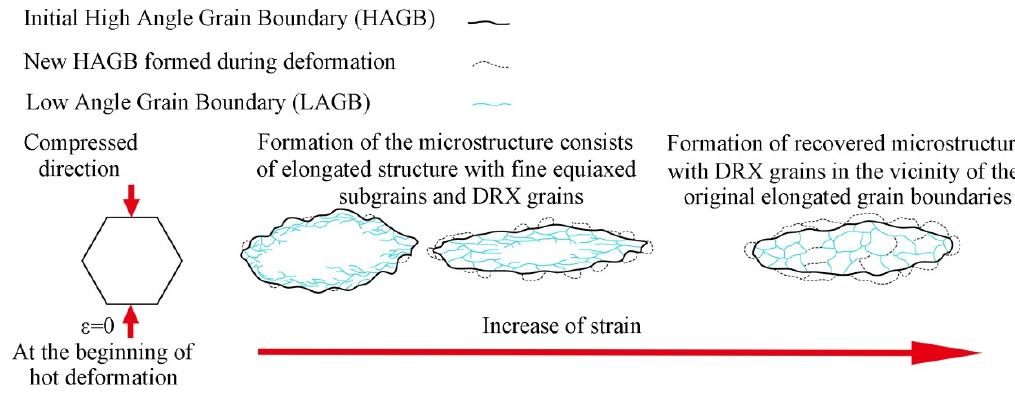
Figure 13. Schematic illustration of the microstructural evolution of Al-Zn-Mg-Cu alloy during hot deformation.